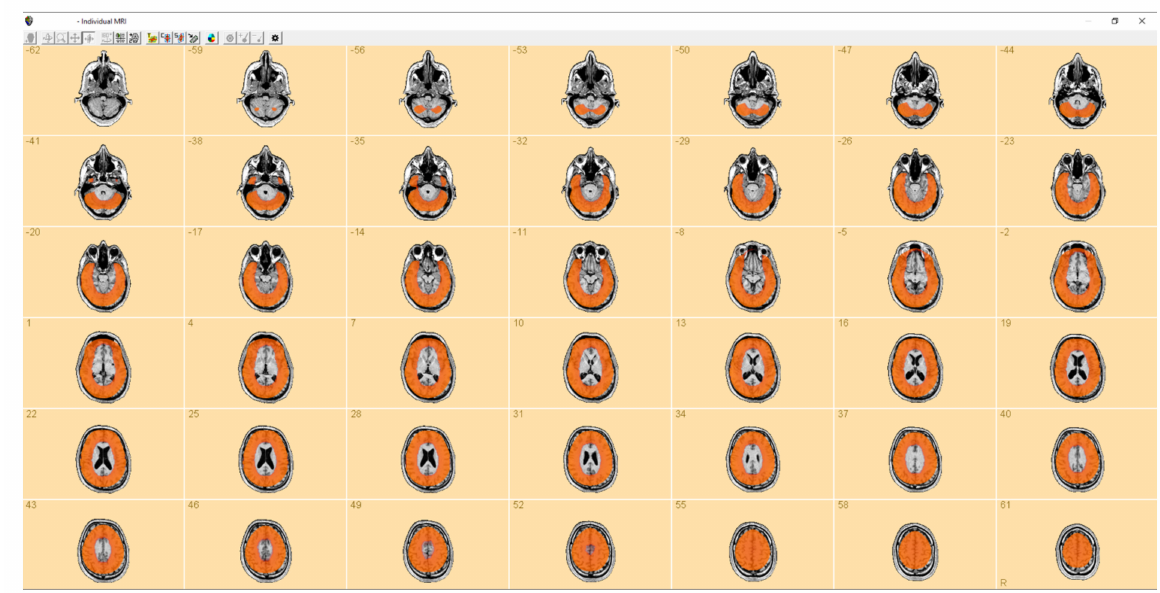
Figure A1. ( a ) Eigenvalues of matrix G with all 306 channels for different regularization values λ . ( b ) Condition number of the regularized matrix G as a function of the regularization parameter between 0 and 5%.